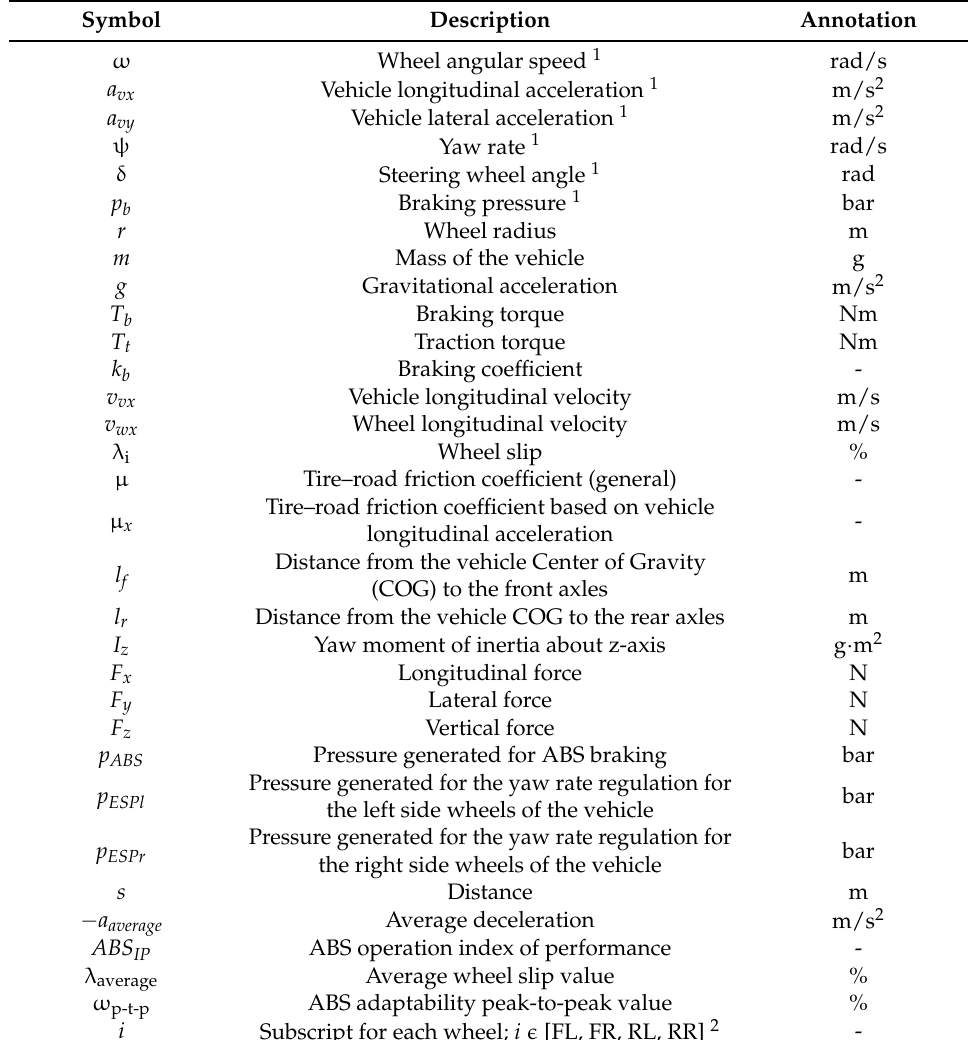
Table 1. Parameters